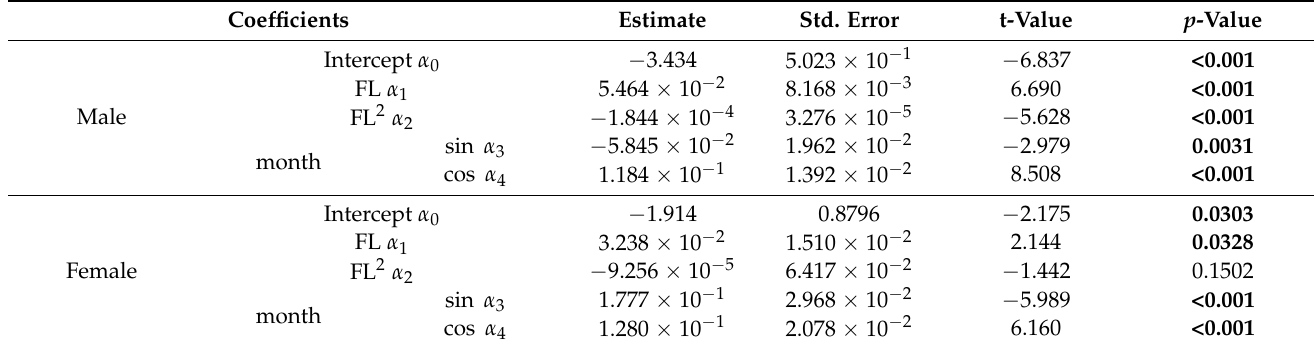
Figure 4. ln(GSI + 1) by FL and month (( a , c ) males; ( b , d ) females). Error bars represent the standard deviations. Table 1. Outputs of generalized linear model (GLM) fitting for gonadosomatic index (GSI) with biological and temporal factors. Significant p -values are formatted in bold